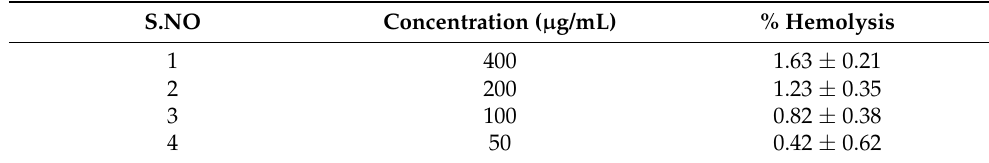
Table 2. % Hemolysis of ZnO-NPs.